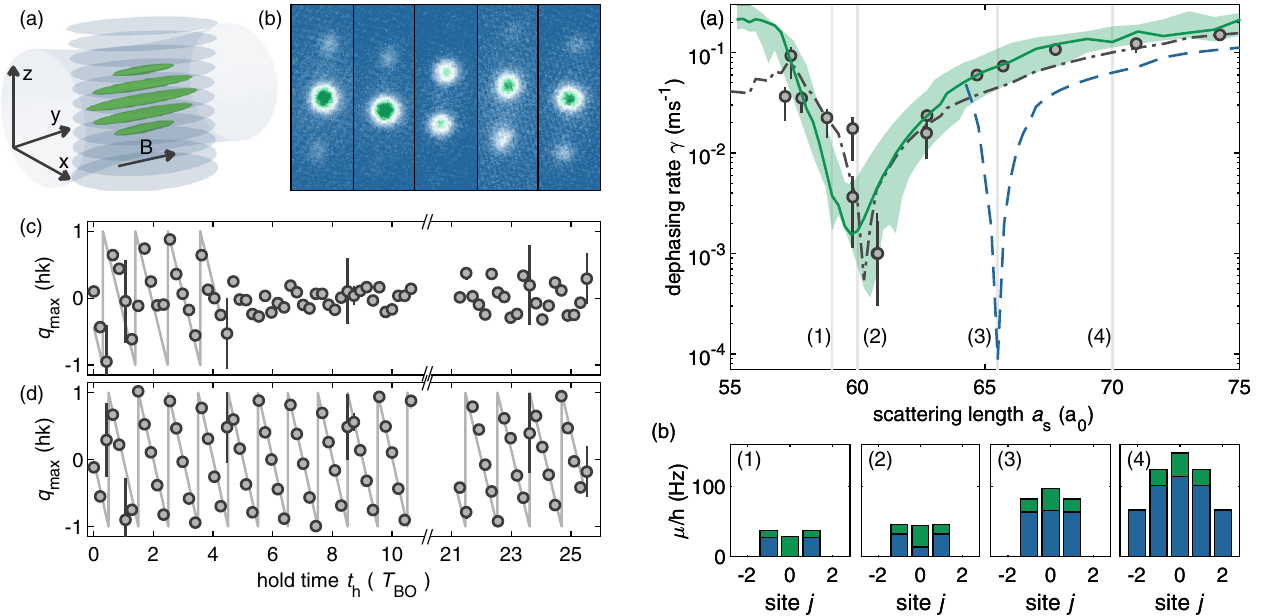
Fig. 2 Dephasing rate and chemical potential distributions. a Experimental dephasing rate γ (circles) as a function of scattering length a s . The green solid line shows the theory result, with an uncertainty region (shaded area) accounting for 20% atom number variation. The blue dashed line shows the theory expectation without Lee-Huang-Yang (LHY). The gray dot-dashed line gives the prediction of the semi-analytic approximation for γ . Error bars show the 68% con fi dence interval (see Supplementary Note 4 for details on the analysis of the momentum distribution during Bloch Oscillation). The statistical uncertainties on the scattering length is smaller than the symbols size. b Chemical potential per lattice site μ j extracted from the discrete model for a s = (59, 60, 65.5, 70) a 0 (1, 2, 3, 4). The green area depicts the LHY contribution to μ j energy functional with respect to the variational parameters to determine the ground states, benchmarking them against the full 3D theory. We then perform dynamic simulations of the expected time evolution (see the “ Methods ” section), giving an accurate dephasing rate (solid line) in Fig. 2a without free parameters. In previous studies 17,18 , the point of minimum dephasing was found to occur when the mean- fi eld interaction energies vanish or cancel. We isolate the mean- fi eld contribution by removing beyond- mean- fi eld effects from our simulations (dashed line in Fig. 2a), predicting a minimum at a s ≈ a dd . However, this is in clear contradiction with our experimental observations by a shift of 6a 0 and a different overall shape due to the different scaling of the LHY term with the density. Without LHY, the cancellation of mean- fi eld energies, E j , is equivalent to the cancellation of onsite chemical MF